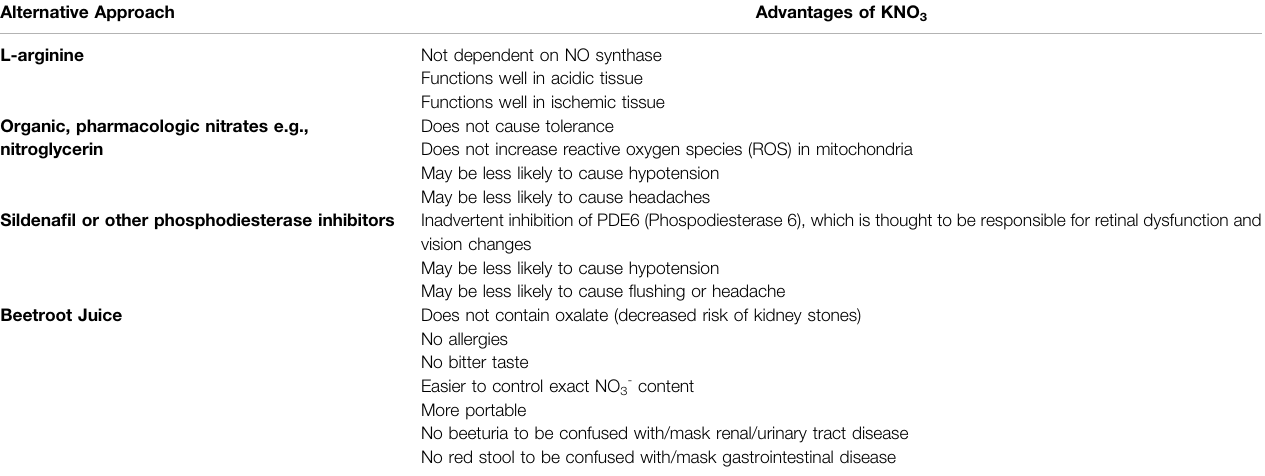
TABLE 1 | Different pathways for enhancing NO and advantages of KNO 3 .